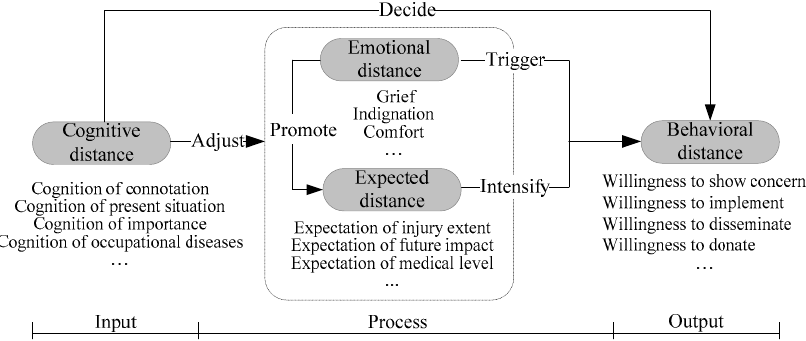
Figure 1. Profile chart of public psychological distance structural relationships in occupational safety and health behaviors.